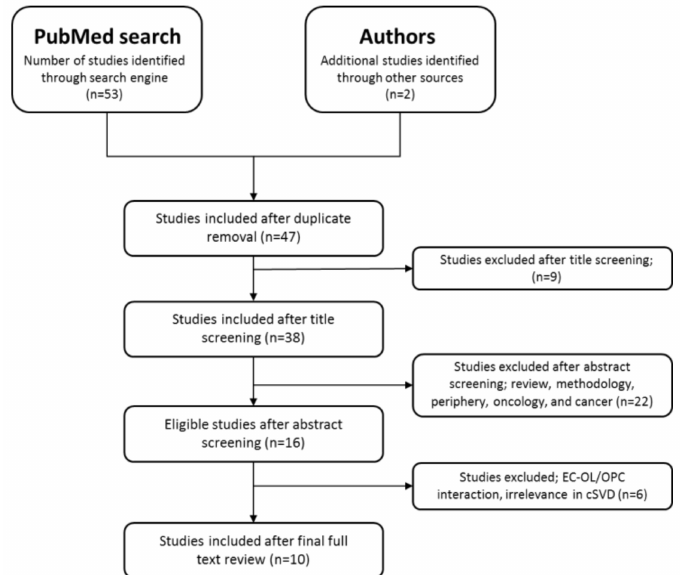
Figure 2. Flow diagram showing the systematic Preferred Reporting Items for Systematic review and Meta-Analysis Protocols (PRISMA-P) search protocol and identification, screening, and extraction of the corresponding studies. ECs, endothelial cells; OLs, oligodendrocytes; OPCs, oligodendrocyte precursor cells; cSVD, cerebral small vessel